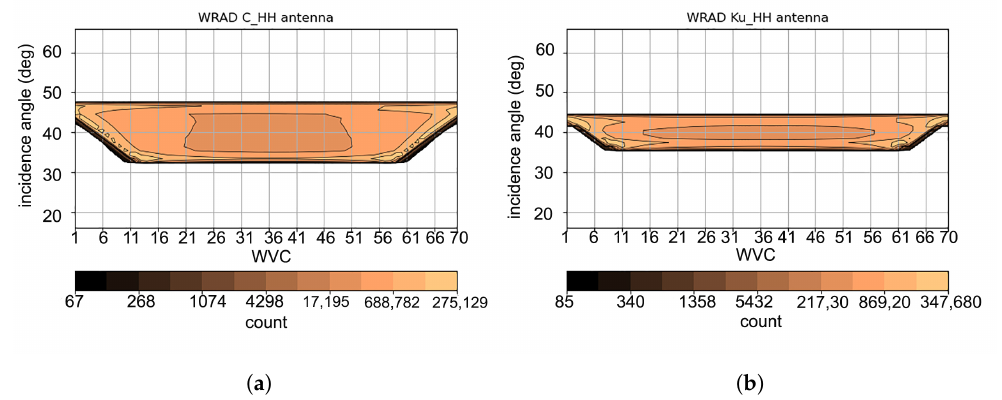
Figure 3. Incidence angle distribution as a function of WVC: ( a ) C-band HH. ( b ) Ku-band